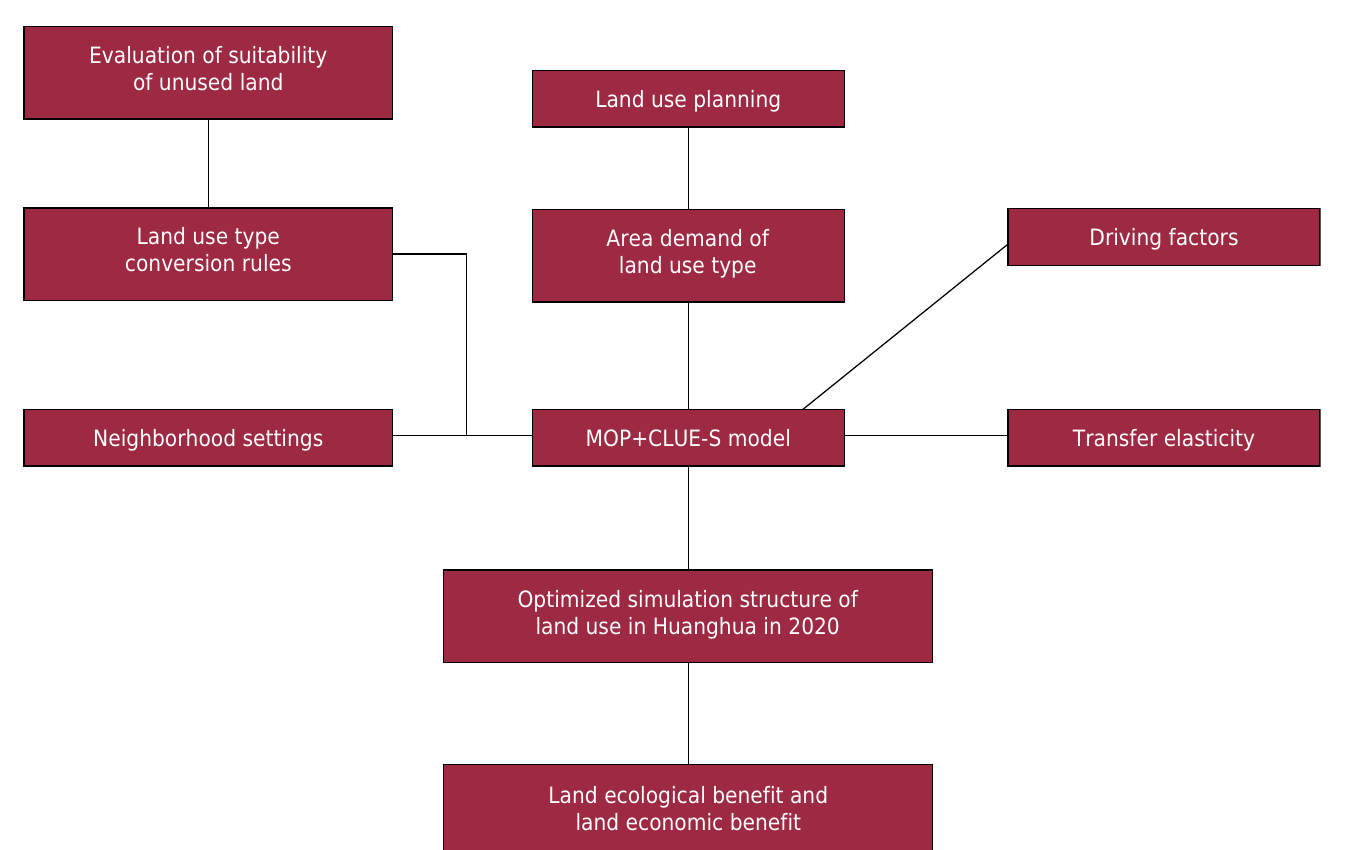
Figure 1. Route map of integrated MOP and CLUE-S-based model simulation in Huanghua City in 2020.